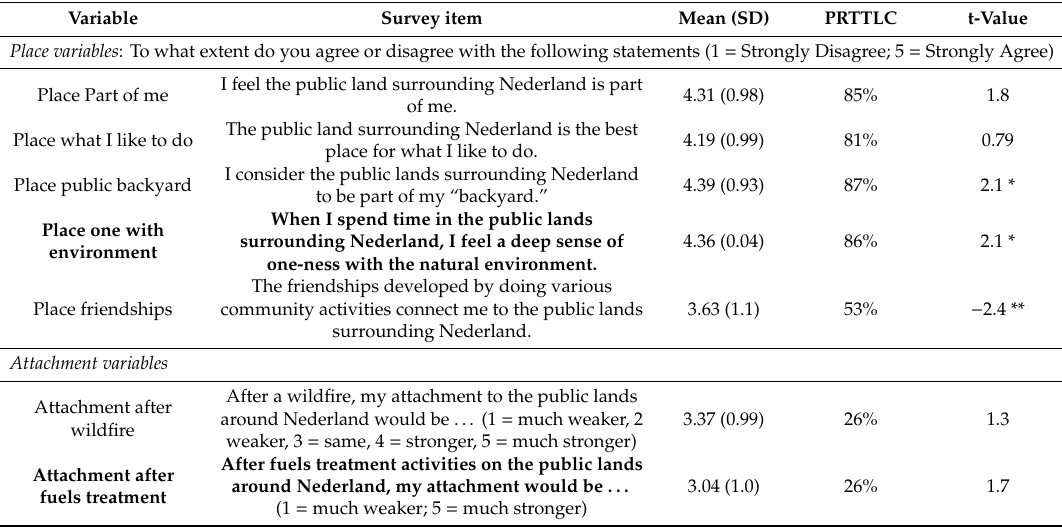
Table 4. Place attachment